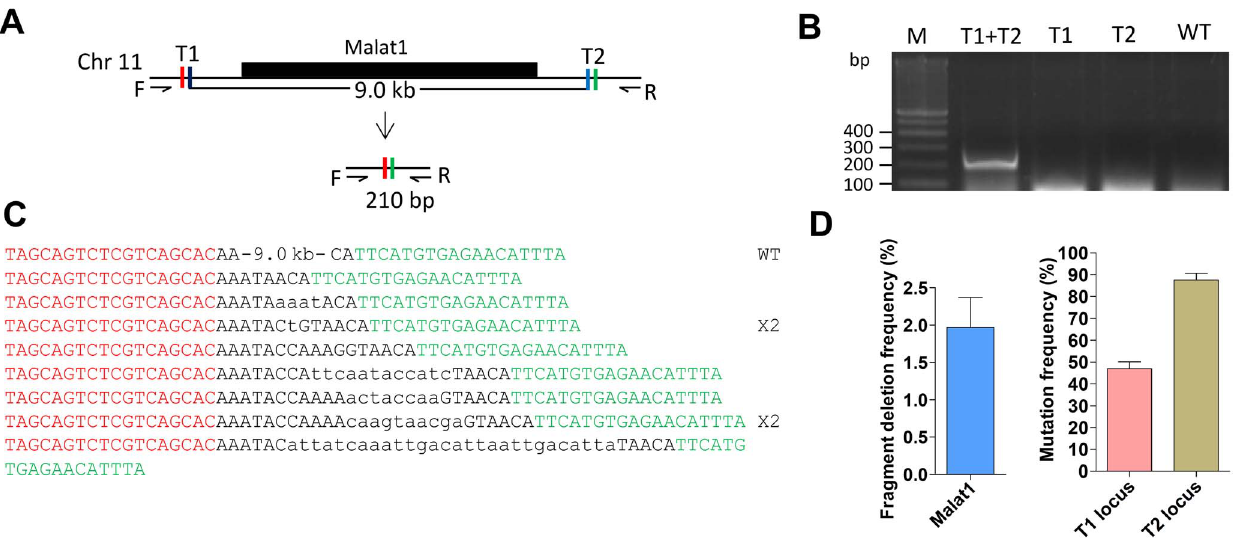
Figure 3. Precise large genomic deletion of a lncRNA gene. ( A ) Schematic representation of the zebrafish lncRNA malat1 and the TALENs designed for its deletion. After the genomic deletion, a band of about 210 bp is expected to be amplified by PCR using the designed primers. ( B ) Genomic PCR showing the deletion of malat1 . Gel picture showing PCR amplification of genomic DNA isolated from the pooled zebrafish embryos microinjected with two pairs of TALENs, one pair of TALENs or the wild-type control. ( C ) Sequencing results confirming malat1 deletions. Alien nucleotides inserted are indicated by lowercase letters. The number of times each mutant allele appearing are shown on the right side of the mutant allele. ( D ) Deletion frequency of the malat1 and mutation frequency of the two targeted loci. Genomic DNA was isolated from pooled zebrafish embryos injected with the two pairs of TALENs. Data shown are mean values 6 S.E.M from three replicates. doi:10.1371/journal.pone.0076387.g003 the engineered nucleases have been mainly used to induce small indel mutations. Because the functional regions of ncRNA gene are often unknown, knockout of an entire ncRNA gene is preferred to eliminate gene function. Here we test whether TALENs could be used to knockout of ncRNA genes in zebrafish.